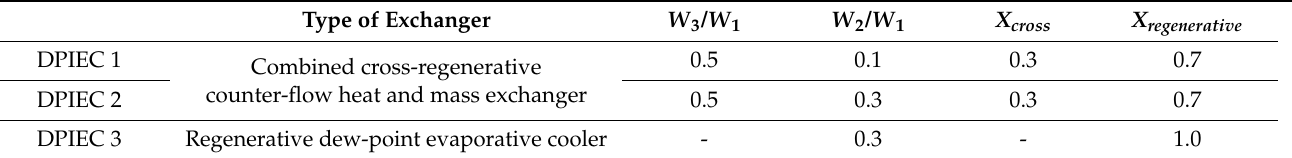
Table 3. Characteristic parameters of the exchangers.